Question: Sum up the contents of this chart in one sentence.
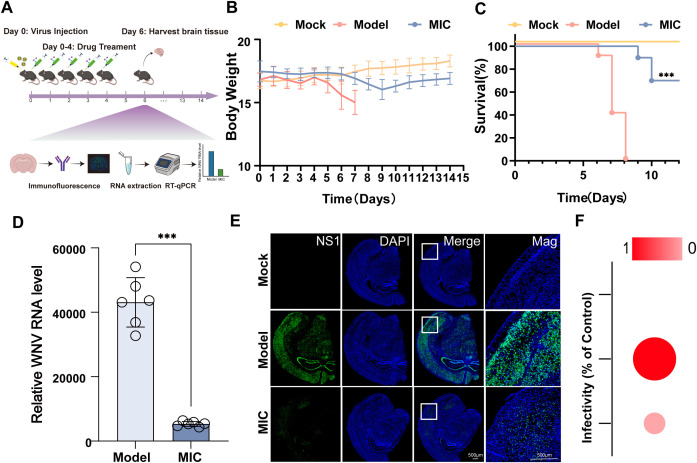
Answer: Miconazole protects mice from lethal WNV infection. Mice were intracranially inoculated with WNV (100 PFU) and treated with miconazole (50 mg/kg) or vehicle daily for 5 days (0–4 dpi). (A) Experimental timeline. (B, C) Body weight and survival (n = 10). (D) Brain viral load at 6 dpi by RT-qPCR (n = 3). (E, F) Brain sections stained for WNV-NS1 (green) and DAPI (blue); boxed areas magnified in insets. Scale bars, 500 μm. ***P < 0.001 vs. model group.